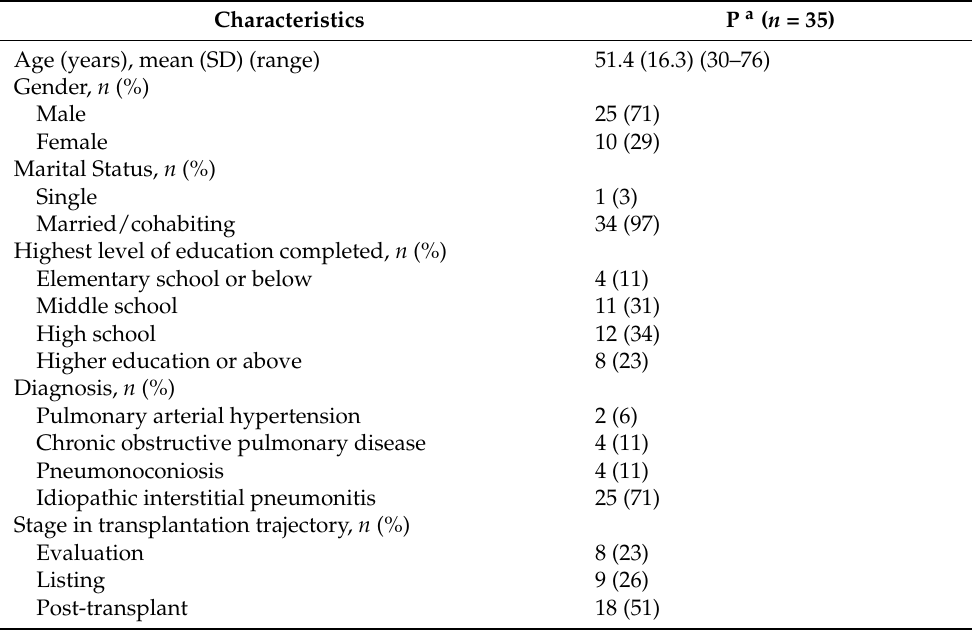
Table 2. Characteristics of participants ( n =